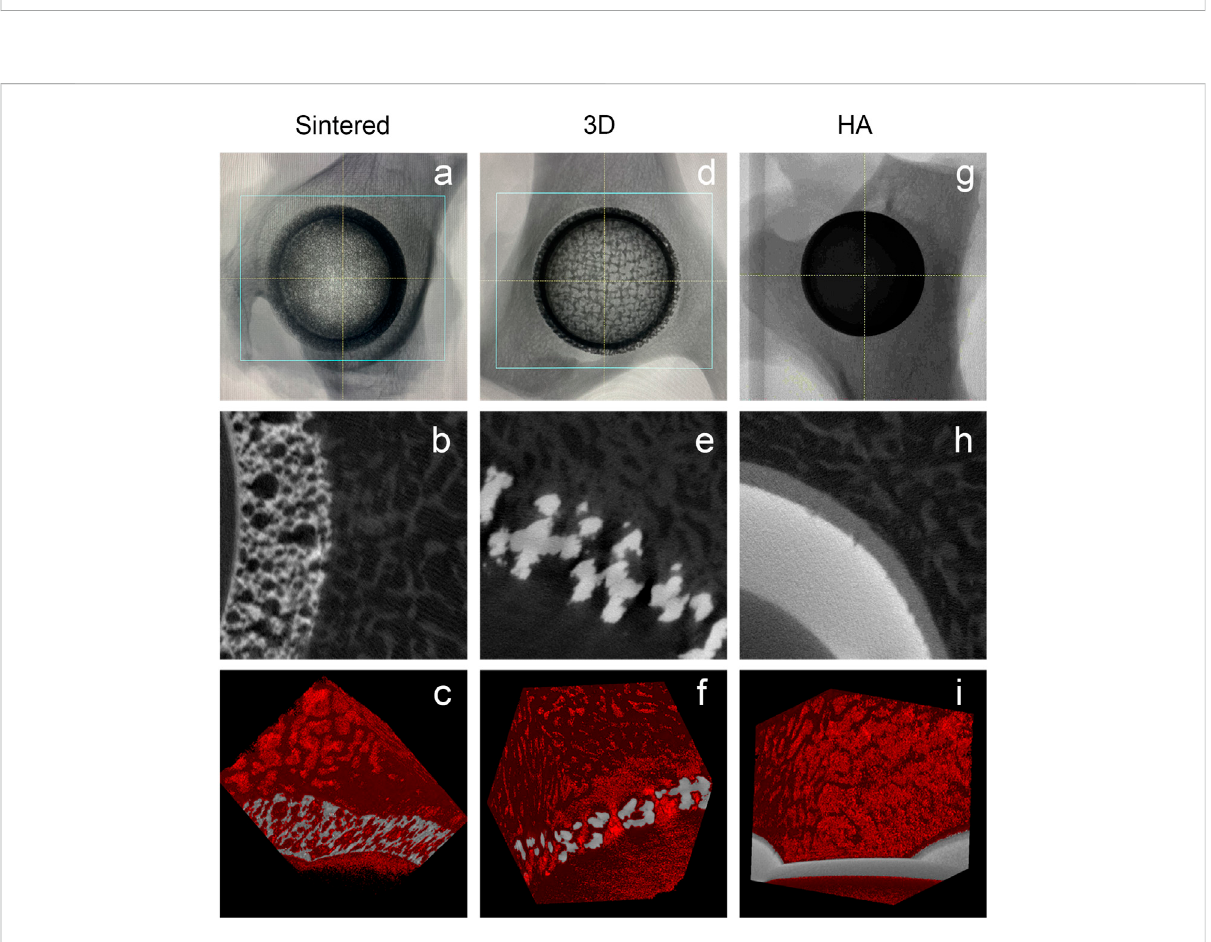
FIGURE 5 MicroCT images of different materials during the follow-up for 6 months. (A – C) Sintered porous titanium alloy acetabular cup; (D – F) 3D- printed porous titanium alloy acetabular cup; (G – I) HA-coated titanium alloy acetabular cup. a, d, and g are the direct specimen imaging of the MicroCTscan;b,e,andharethetwo-dimensionalspecimenimagingoftheMicroCTscan.Inthe fi gure,thegray-whiteisthetitaniumimage,andthe gray-black isthe bone trabecular structure; c, f,and i are the specimen 3Dreconstruction imaging of the MicroCT scan. Titanium alloy image is in gray, and the 3D reconstruction image of bone trabeculae is in